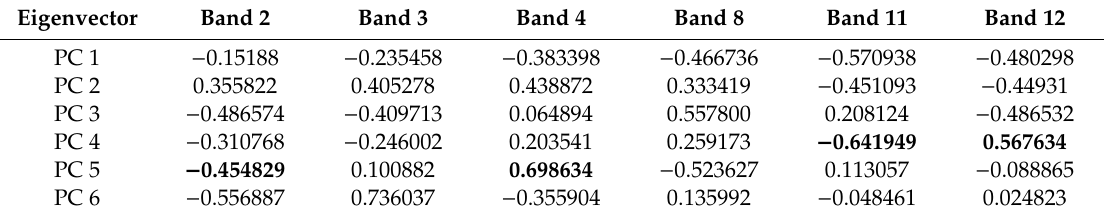
Table 3. Eigenvector matrix derived from PCA for the selected bands of Sentinel-2 bands (2, 3, 4, 8, 11, 12) used in this study.